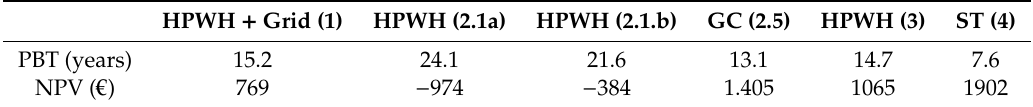
Table 5. Payback time and net present value (without national incentive).